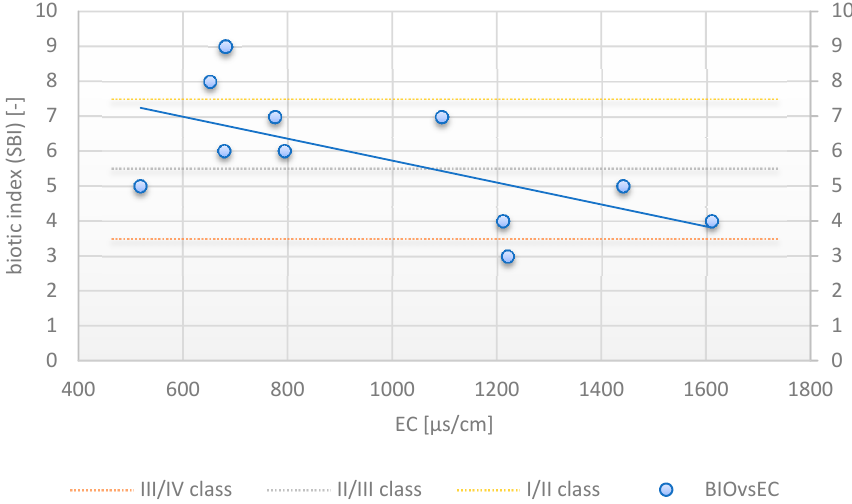
Figure 7. Correlation between EC of the effluent and sludge biotic index in tested container on-site wastewater treatment plant. Horizontal lines mark the borders between classes of activated sludge. Each class reflects different sludge quality (see Table 4).